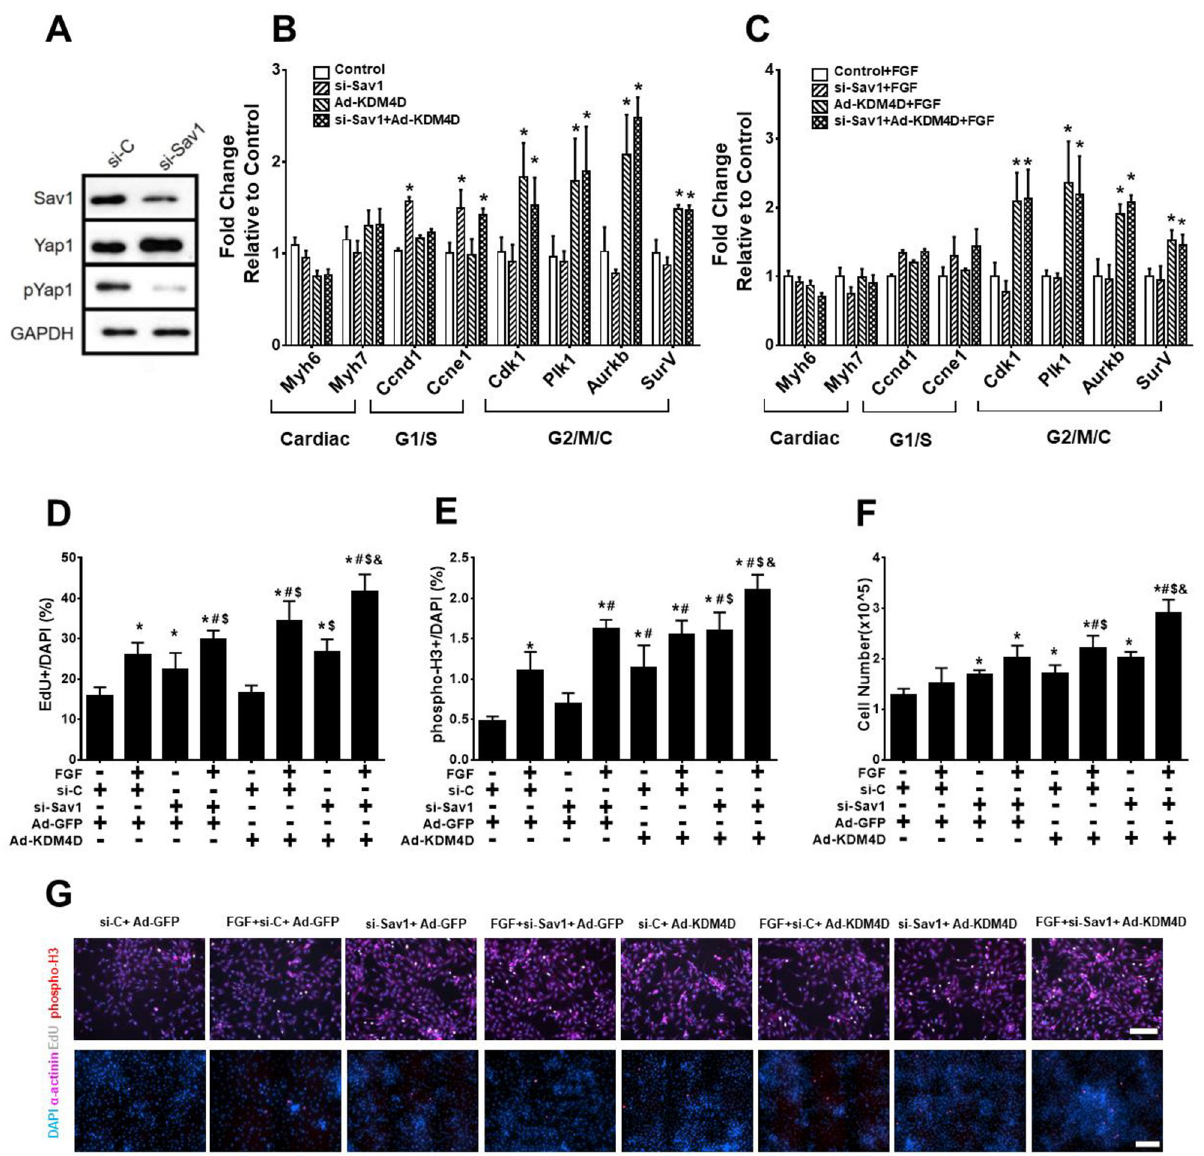
Fig 3. Effect of KDM4D and si-Sav1 on NRVM cell cycle activity. (A) Representative western blot of cell lysates from NRVMs after 3 days of Sav1 knockdown 199 (representative data from one of the three replicates). (B) Expression of cell cycle genes in Ad-KDM4D and si-Sav1 treated NRVMs. (C) Effects of adding FGF to Ad-KDM4D and si-Sav1 on cell cycle gene expression. (D) EdU + incorporation in NRVMs treated with Ad-KDM4D and/ or si-Sav1, and FGF. (E) phospho-H3 + immunostaining in NRVMs treated with or without Ad-KDM4D, si-Sav1, and FGF. (F) Total NRVM number after indicated treatments. (G) Representative photomicrographs showing EdU/phospho-H3 immunostaing after different treatments. EdU, bar = 100 μ M; phospho-H3, bar = 200 μ M. Statistics: � showed statistical significance at p < 0.05 vs control (without si-Sav1, Ad-KDM4D, and FGF); # represented statistical significance at p < 0.05 vs si-Sav1; $ mean statistical significance at p < 0.05 vs Ad-KDM4D; & showed statistical significance at p < 0.05 vs si-Sav1+Ad-KDM4D. One-way ANOVA followed by Tukeys’ Test; n = 3 for all the experiments.